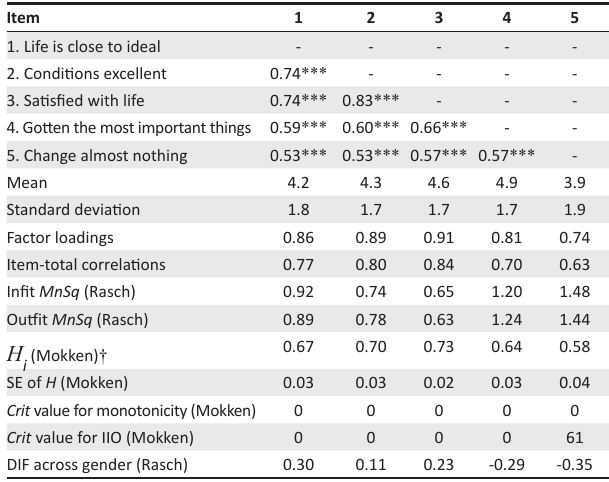
TABLE 2: Classical test theory and item response theory indices for the Satisfaction with Life Scale at the item level. Item 1 2 3 4 5 1. Life is close to